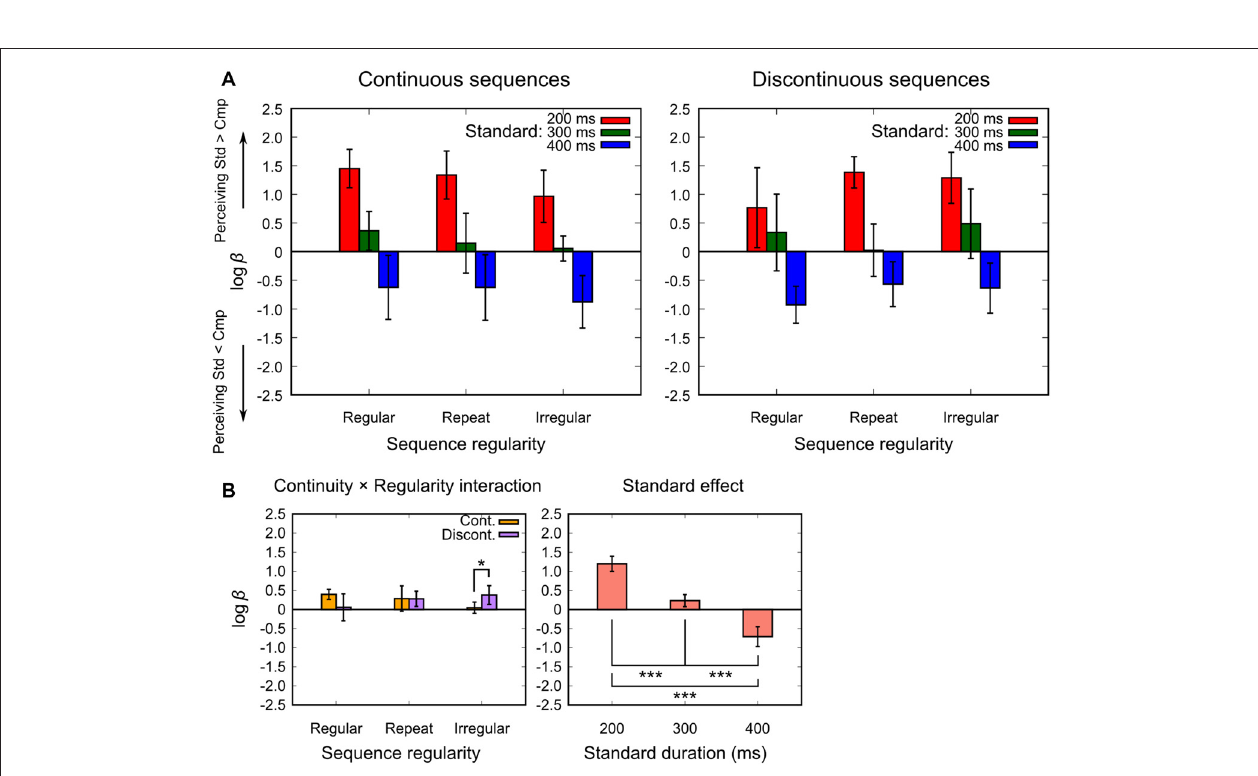
FIGURE 6 | Mean log β for each experimental condition of the regularity-varied session (A) , and the results of the post hoc contrasts for the continuity × regularity interaction and the standard effect that were significant in the omnibus ANOVA (B) . Bars represent 95% confidence intervals. Asterisks indicate significant differences ( ∗ p < 0.05, ∗∗∗ p <